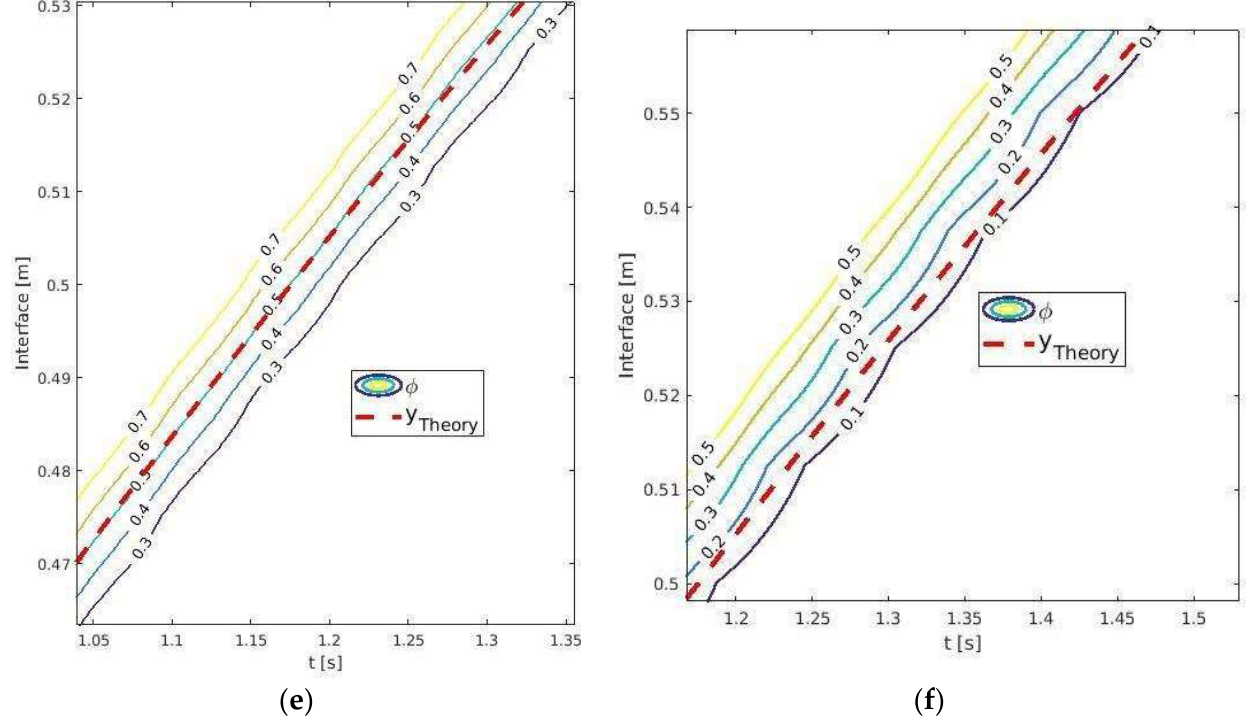
( e ) ( f ) Figure A2. Present model Vs explicit model for different grid resolution: grid 20 × 20: ( a , b ); grid resolution 40 × 40: ( c , d ); grid resolution 80 × 80: ( e , f ).